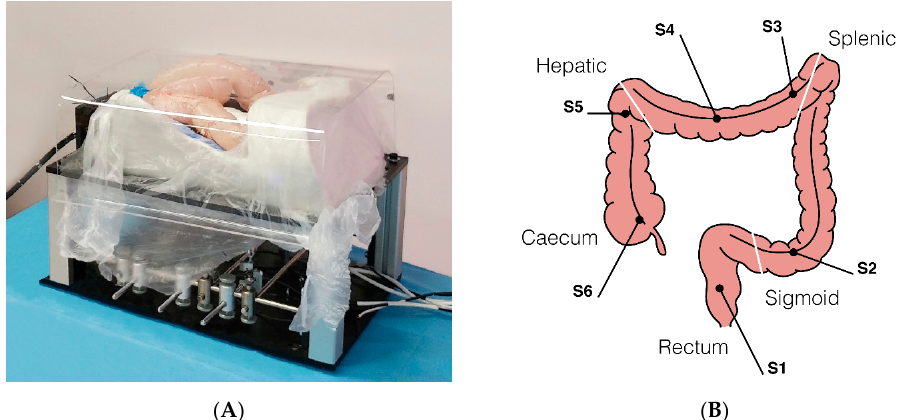
Figure 4. ( A ) Ex-vivo colon phantom with sensors for measuring the forces exerted on the tissue during the procedure (sensorized phantom developed by OVESCO Endoscopy AG, Tübingen, Germany). ( B ) Positions of the 6 monoaxial strain gauge sensors along the colon (S1, upper rectum; S2, mid-sigmoid tract; S3, splenic flexure; S4, mid-transverse colon; S5, hepatic flexure; S6, cecum).